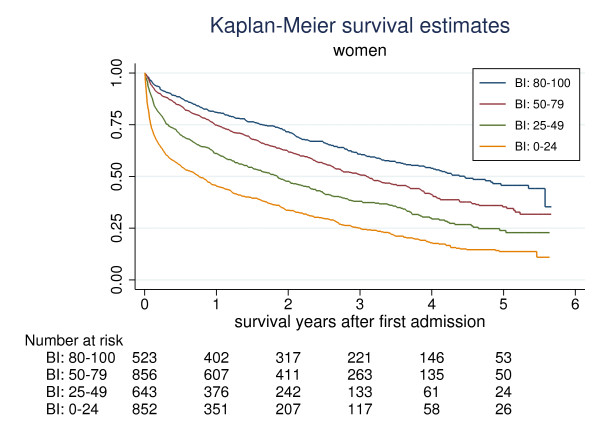
Kaplan-Meier survival estimates in women stratified on Barthel Index (BI) measured at admission. BI: 80-100 (blue), 50-79 (red), 25-49 (green), 0-24 (yellow)